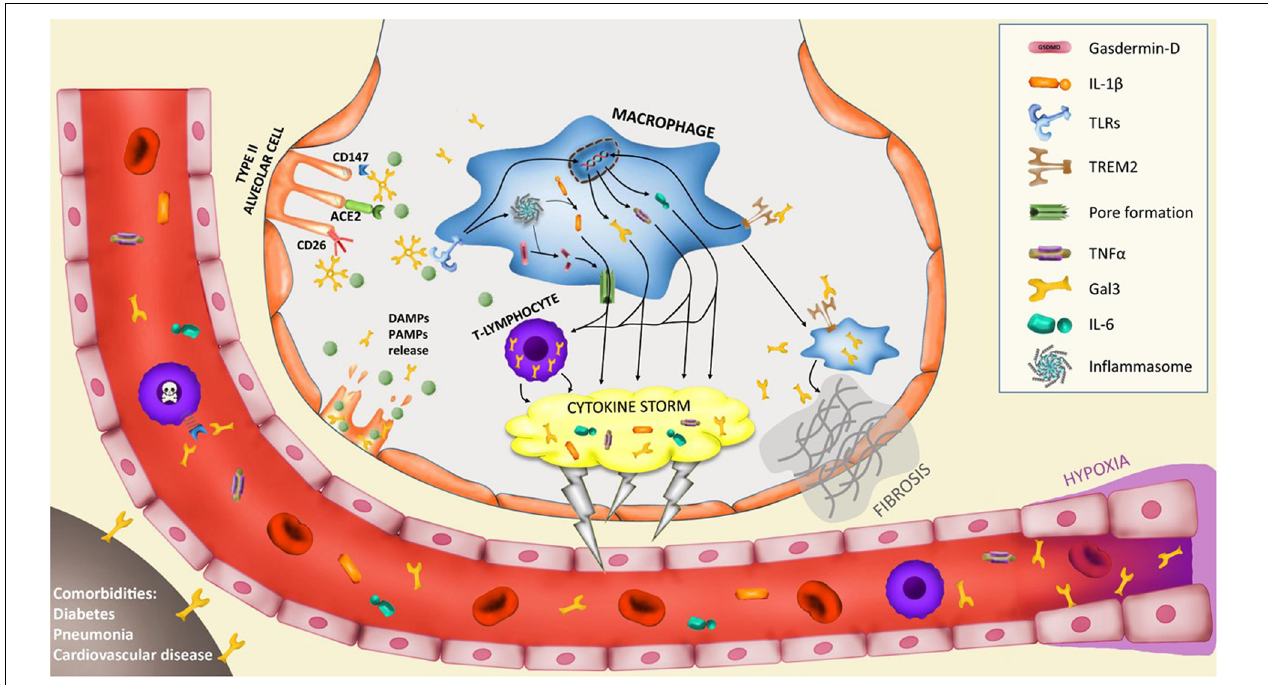
FIGURE 1 | Potential implication of galectin-3 in the pathogenesis of severe COVID-19 cases. Infection of type II alveolar cells by SARS-CoV-2 is driven by ACE2-spike protein interaction and supported by CD147 and CD26 interaction. Gal3 can mediate ligand-receptor interaction by glycan recognition of spike protein and interaction with receptors. In particular, CD147-spike protein interaction promotes apoptosis of T-lymphocytes provoking systemic lymphocytopenia syndrome. Lysis of infected cells provoke the secretion of DAMPs and PAMPs recognized by alveolar macrophages receptors like triggering receptor expressed on myeloid cells 2 (TREM2) or toll-like receptors (TLRs) that trigger the upregulation of several cytokines including IL-6, TNF α and gal3. TLRs activation induces the assembly of the macromolecular platform known as inflammasome that promotes the cleavage of pro-IL-1 β into active IL-1 β and the cleavage of gasdermin-D (GSDMD), thus promoting pores formation in the cell membrane and induce the secretion of IL-1 β . This macrophage activation triggers the hyperinflammation phase called “cytokine storm” and is supported by lymphocyte infiltration and proliferation with high expression of gal3 that contributes to the cytokine storm. The macrophage activation is composed of several phenotypes. A subset of macrophages develop a pro-fibrotic phenotype controlled by TREM2 and gal3 expression that triggers lung fibrosis. Moreover, hypoxia triggers gal3 expression by endothelial and smooth muscle cells. Lastly, comorbidities like diabetes, pneumonia or cardiovascular diseases increase basal levels of plasma gal3 what would contribute to COVID-19 severe